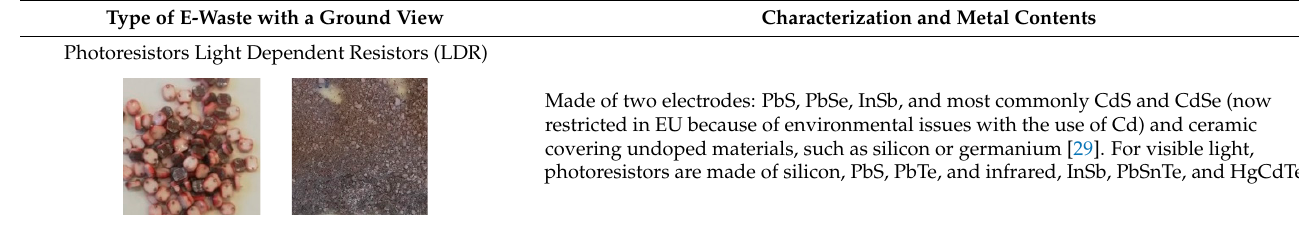
Table 2. Speci fi cations of e-waste samples used in the study Table 2. Specifications of e-waste samples used in the study.